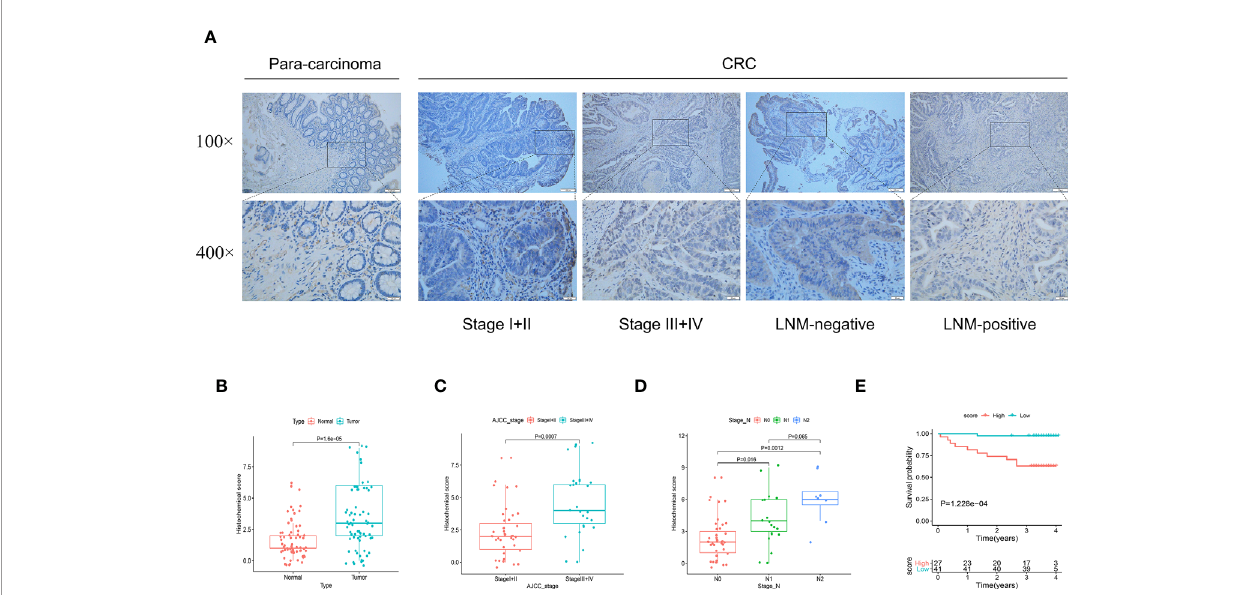
FIGURE 7 | Validation the protein function of FSTL3 by immunohistochemistry in external cohort. (A, B) FSTL3 protein was signi fi cantly overexpressed in tumor tissues. Scale bars, 100 and 20 m m. (C, D) FSTL3 protein is strikingly correlated to AJCC stage ( P = 0.0007) and LNM ( P < 0.05). (E) The survival analysis showed that CRC patients with higher FSTL3 protein has shorter OS compared with lower FSTL3 protein group ( P = 1.228e-4).